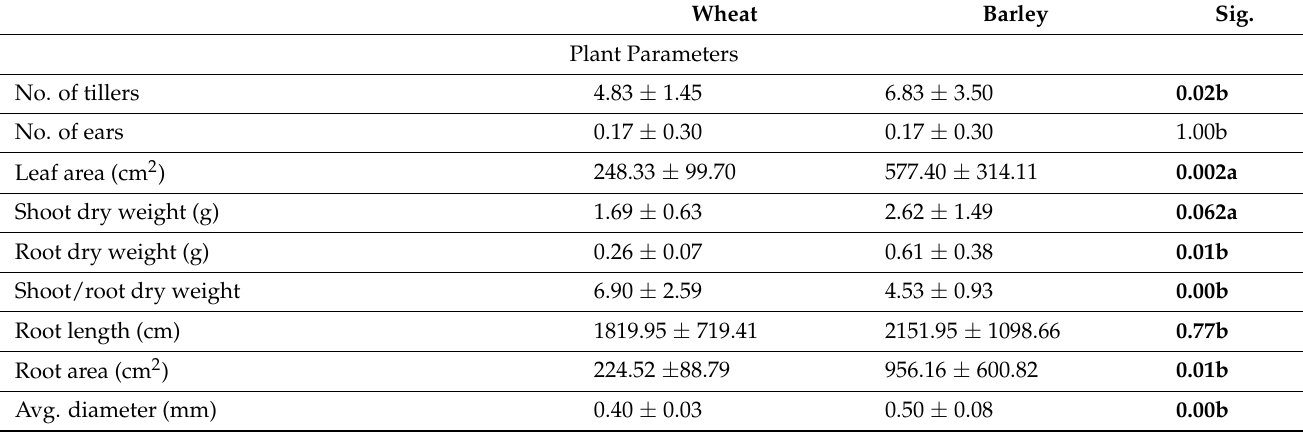
Table 3. The effect of dried algae biomass on the early growth stage (7 weeks) of wheat and barley biomass (7 weeks). No. = number, Avg. = average, TN = total nitrogen, P = phosphorus, T = top soil sample, B = bottom soil sample, R = rhizosphere soil sample, mix = mixed soil sample sig. = significance of the